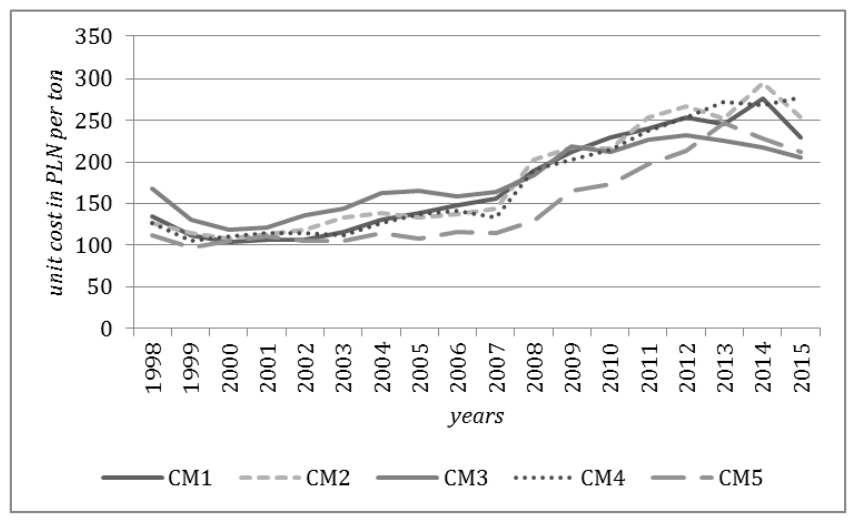
Figure 4. Unit costs in examined coalmines over the period 1998–2015 (PLN per ton). Source: own work.